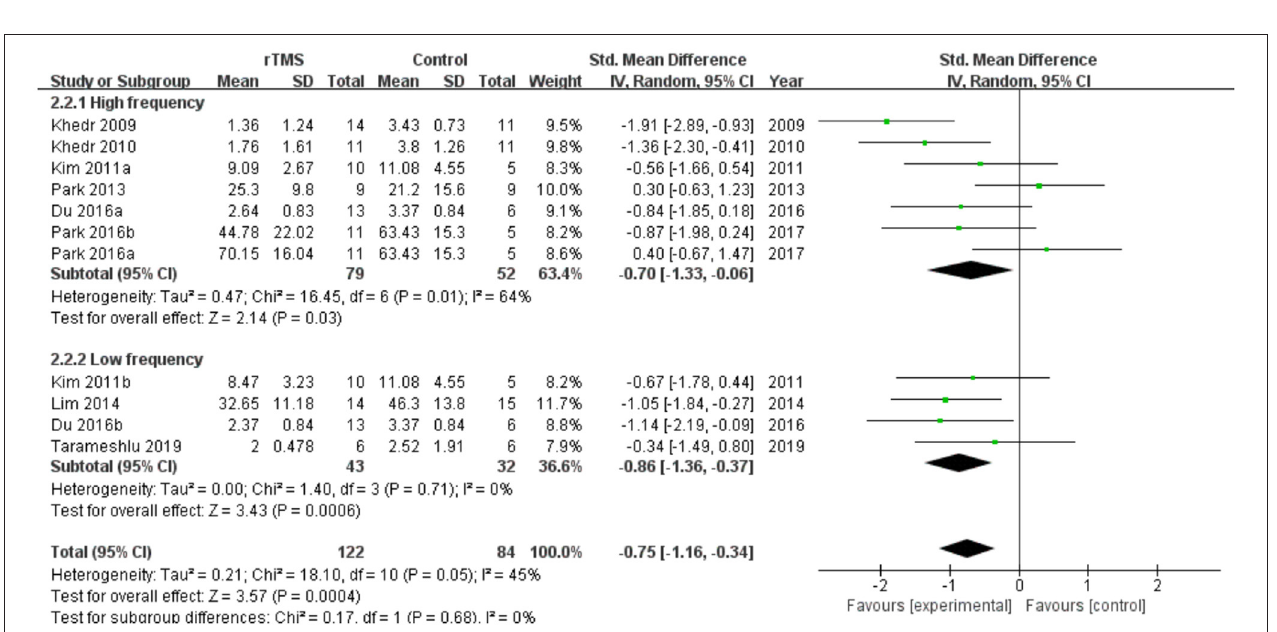
FIGURE 5 | Forest plot for subgroup analysis for overall swallowing function: ipsilesional hemisphere vs. contralesional hemisphere vs. bilateral hemispheres.